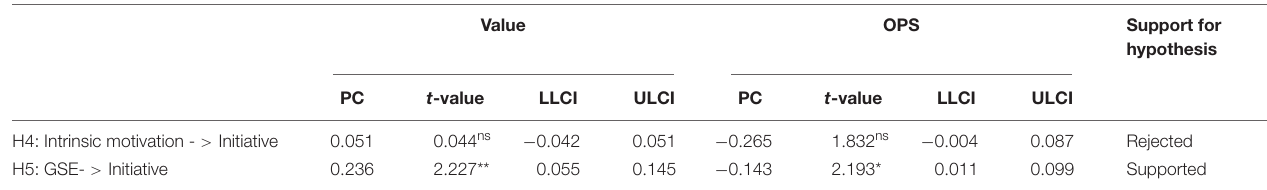
TABLE 3 | Moderation coefficients, t -values, and support for the